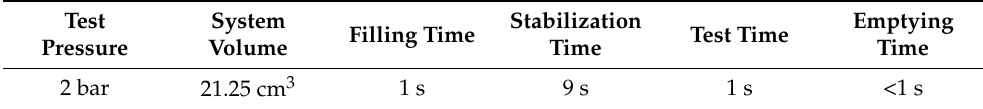
Table 4. Values adopted for the leak test.